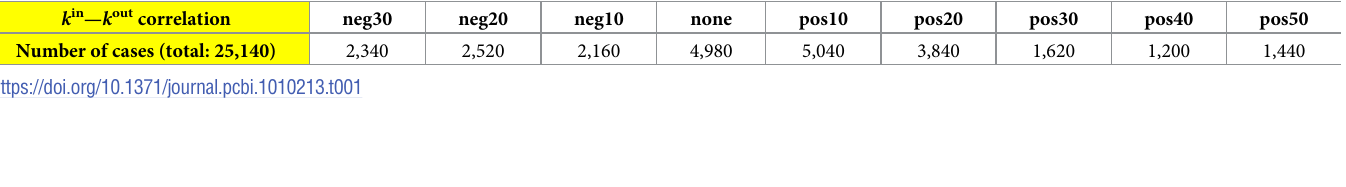
Table 1. The number of different SCN network morphologies that are selected for the SCN model simulation and screened for their suitability as an SCN model [listed for different levels of indegree-outdegree correlation; see Fig 3A (and Sec. 1 in S1 Text) for the meaning of the labels]. k in — k out correlation neg30